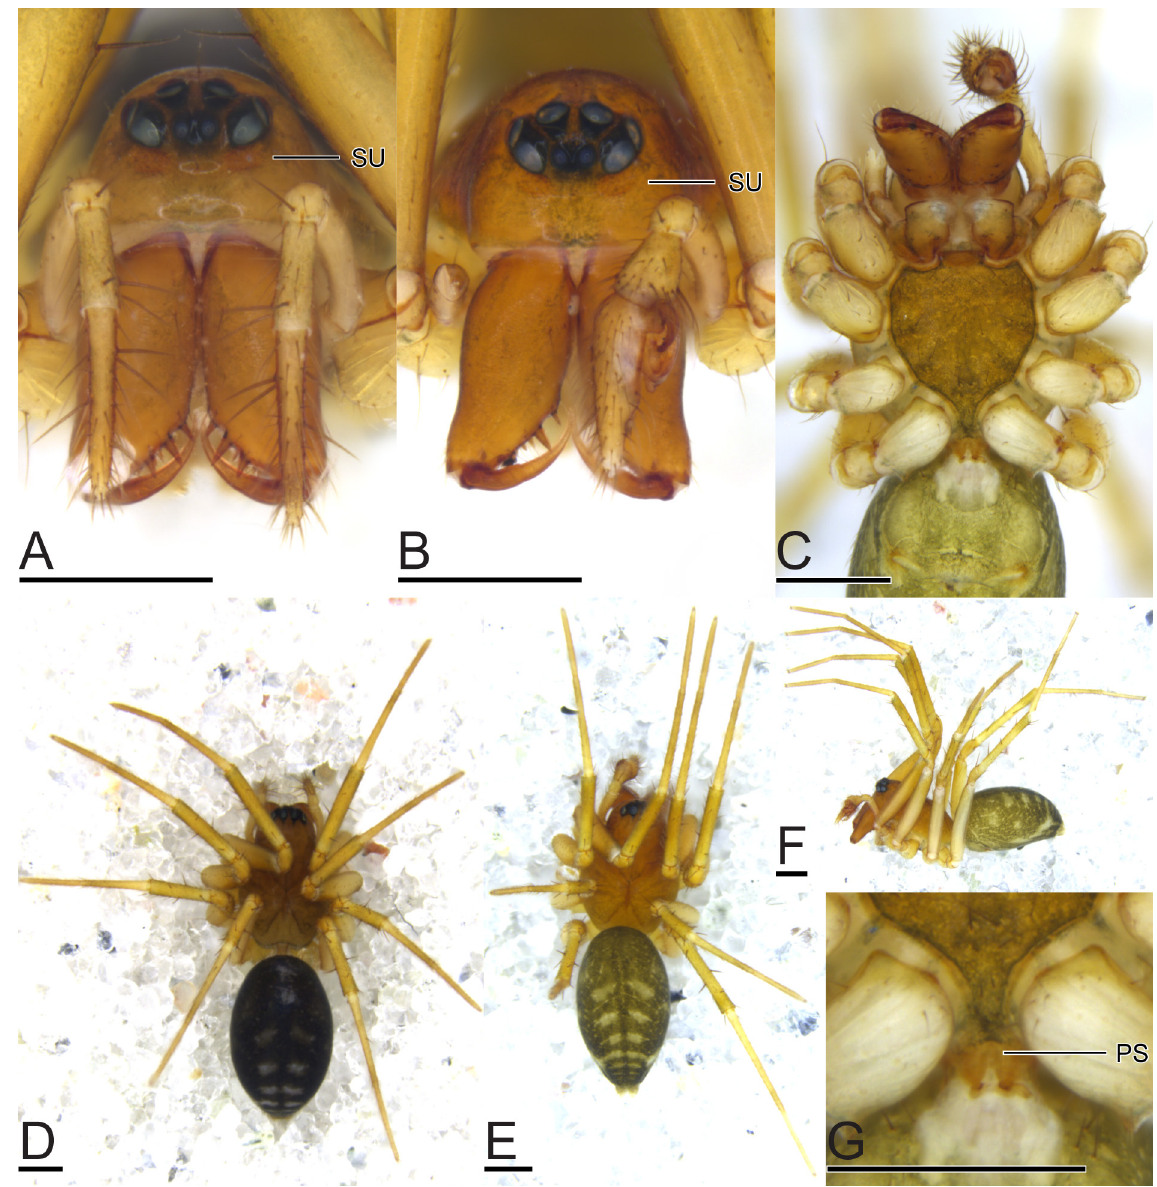
Fig. 3. Camafroneta oku gen. et sp. nov. A , D . Allotype, ♀ (ZMUC00046889). B , C , E–G . Holotype, ♂ (ZMUC00046889). A . Habitus, frontal. B . Habitus, frontal. C . Sternum. D . Habitus, dorsal. E . Habitus, dorsal. F . Habitus, lateral. G . Petiolus, ventral. Scale bars: